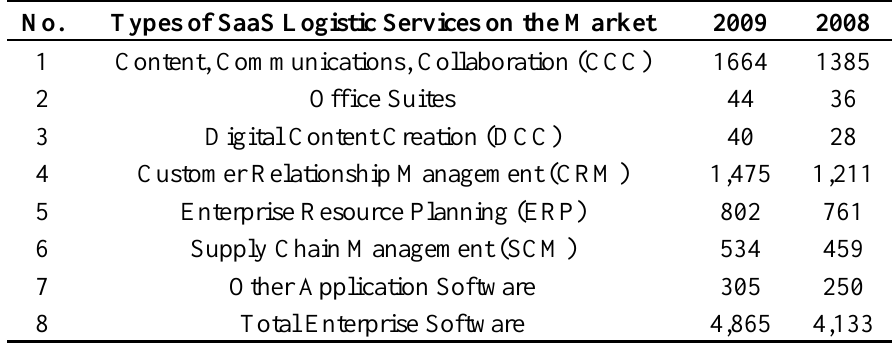
Table 1. Types and output value of SaaS logistic services on the global market. (Billion USD).